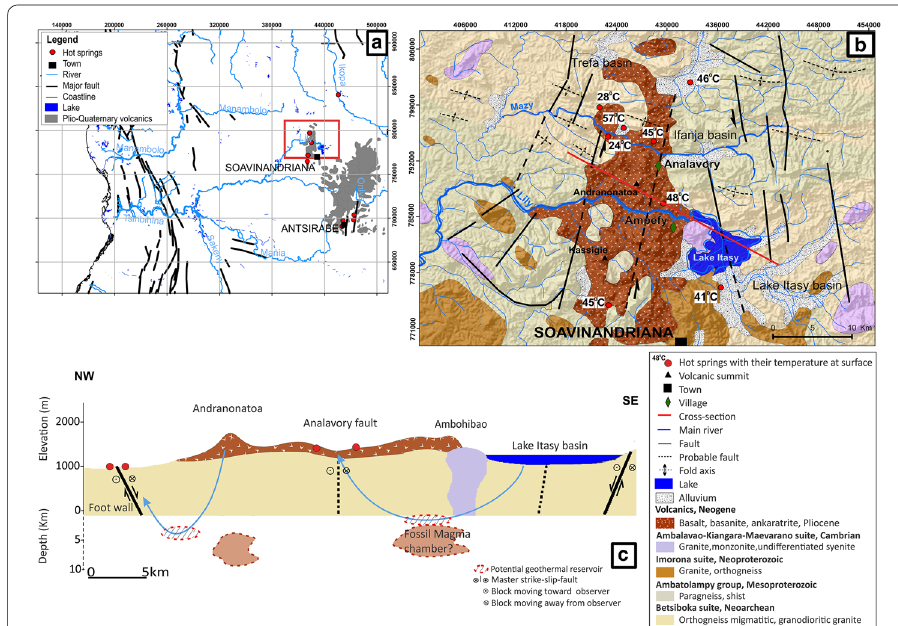
Fig. 4 a Location of the Itasy geothermal area, b detailed geology showing the position of thermal springs, modified from Andrianaivo and Ramasiarinoro (2010a, b), and c conceptual model of the Itasy pull-apart basin geothermal system, modified from Andrianaivo and Ramasiarinoro (2010a, b). The vertical scale of the elevation profile, which was created using ASTER imagery, has been exaggerated compared to the depth scale, which is based on the structure of the crust and uppermost mantle beneath Madagascar (Andriampenomanana et al.